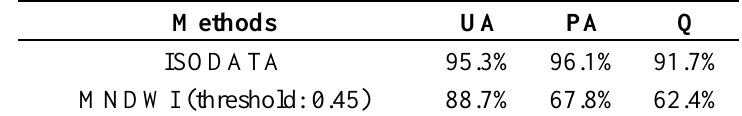
Table 2. The unsupervised classification accuracy of different input bands at the Bow River